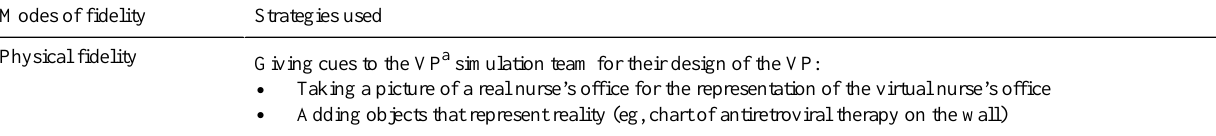
Table 1. Strategies used to ensure 3 modes of fidelity throughout the virtual patient simulation. Strategies usedModes of